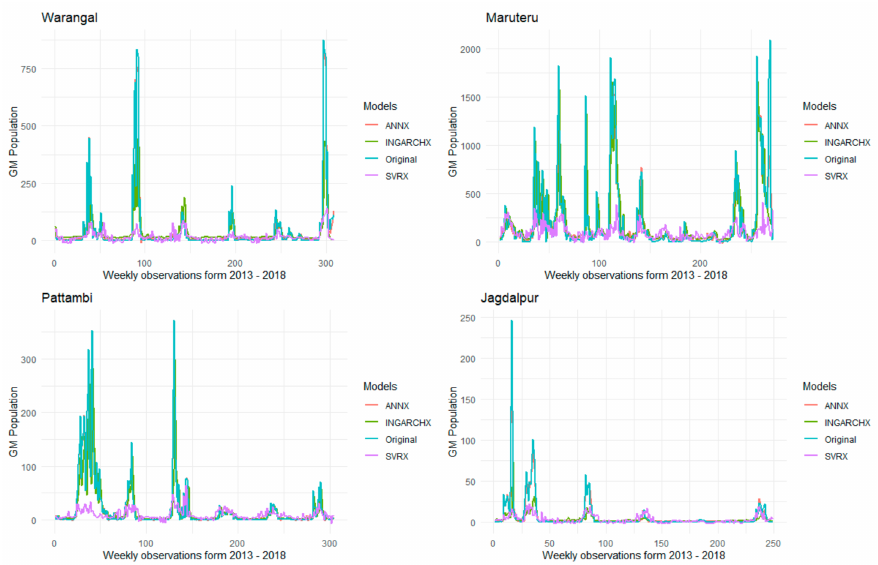
Figure 4. Actual vs. fitted plots of gall midge population. Table 7. Diebold–Mariano test for comparison of performance of different models with training and testing data sets at study